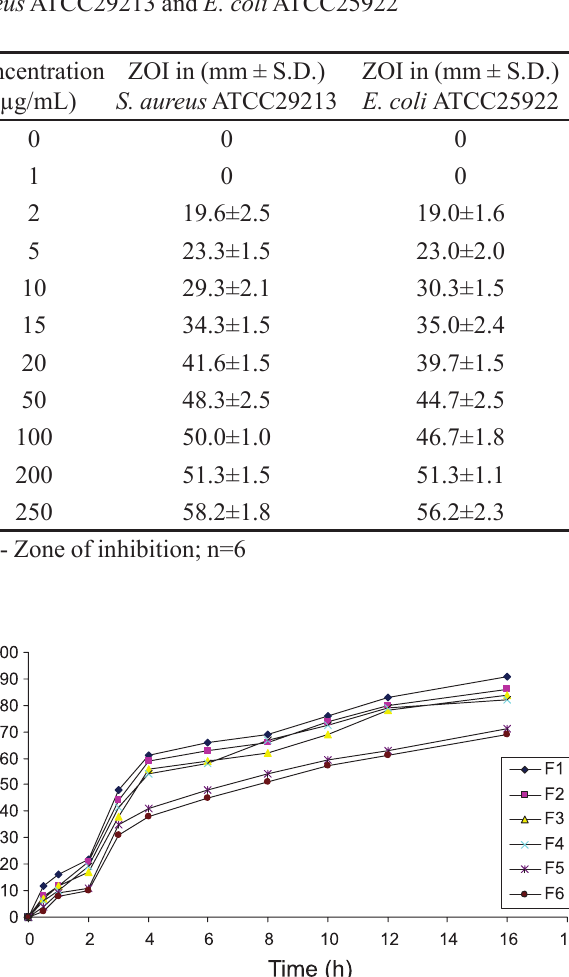
TABLE IV - Antibacterial activity of control samples against S. aureus ATCC29213 and E. coli ATCC25922